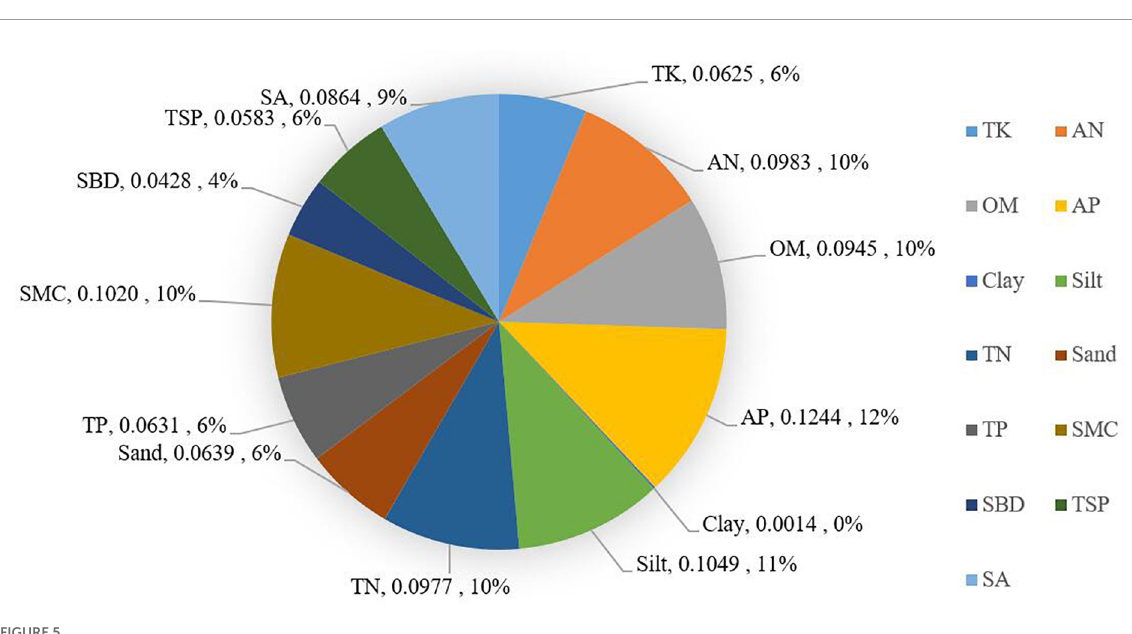
FIGURE5 Weight and proportion of each